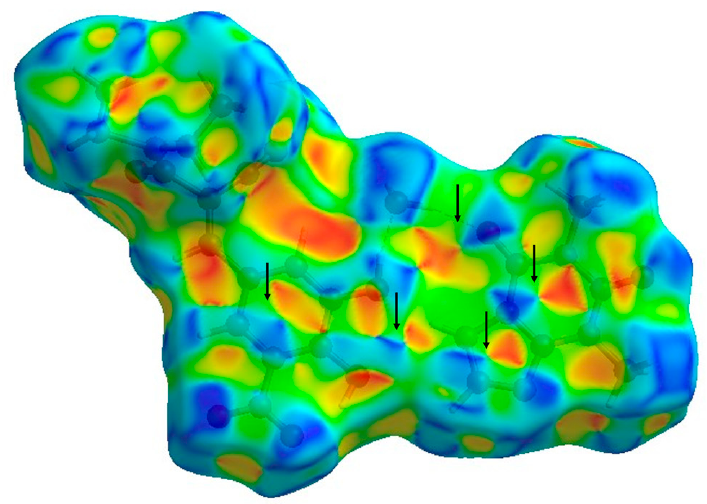
Figure 7. Hirshfeld surface mapped over shape-index for ENT-THP-water cocrystal. Arrows show the presence of π - π stacking interactions.